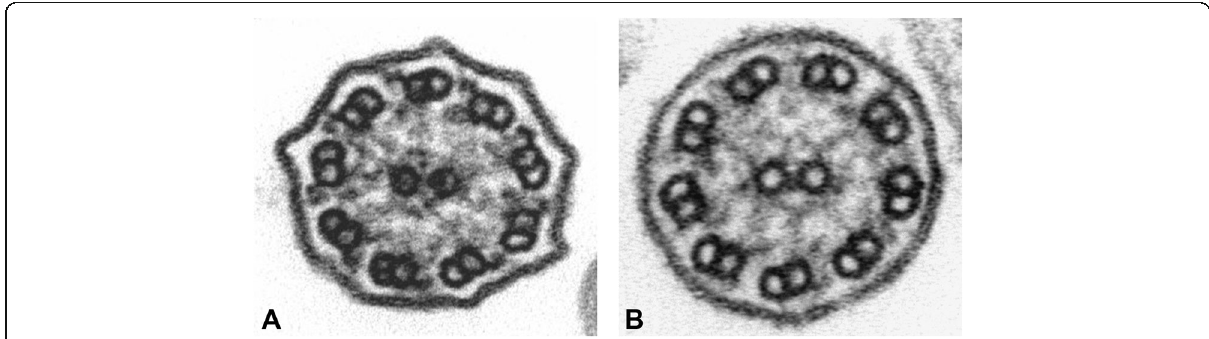
Fig. 1 a Ultrastructure of a normal cilium from nasal epithelium of a healthy subject showing nine peripheral pairs of microtubules with outer and inner dynein arms clearly visible (100.000 x). b Representative transmission electron micrograph of a cross-sectioned cilium from the patient demonstrating the absence of outer dynein arms